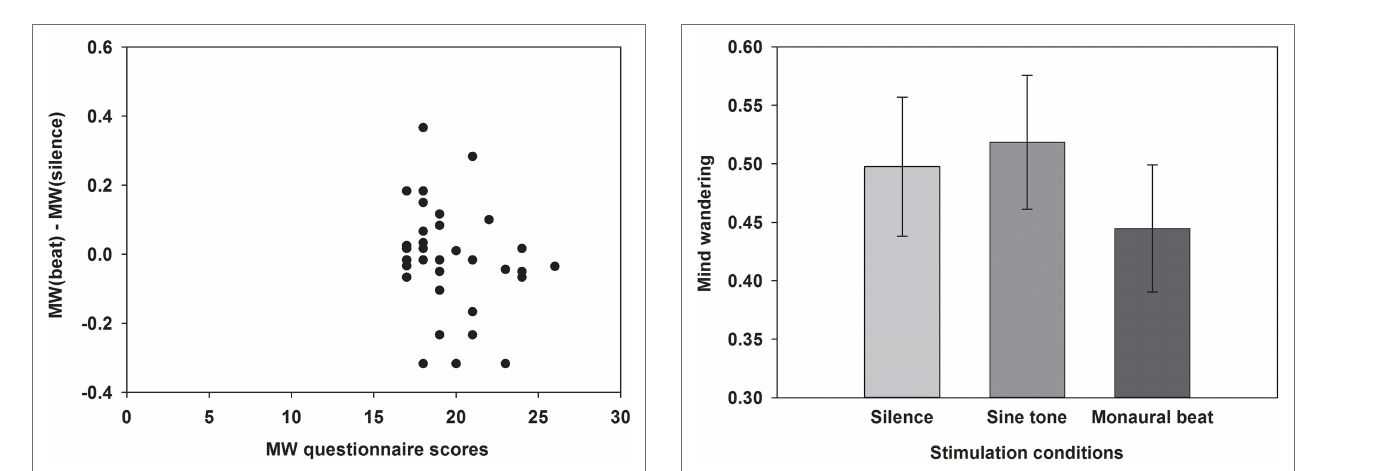
TABLE 2 | Summary table of Spearman’s correlations with MW propensities.